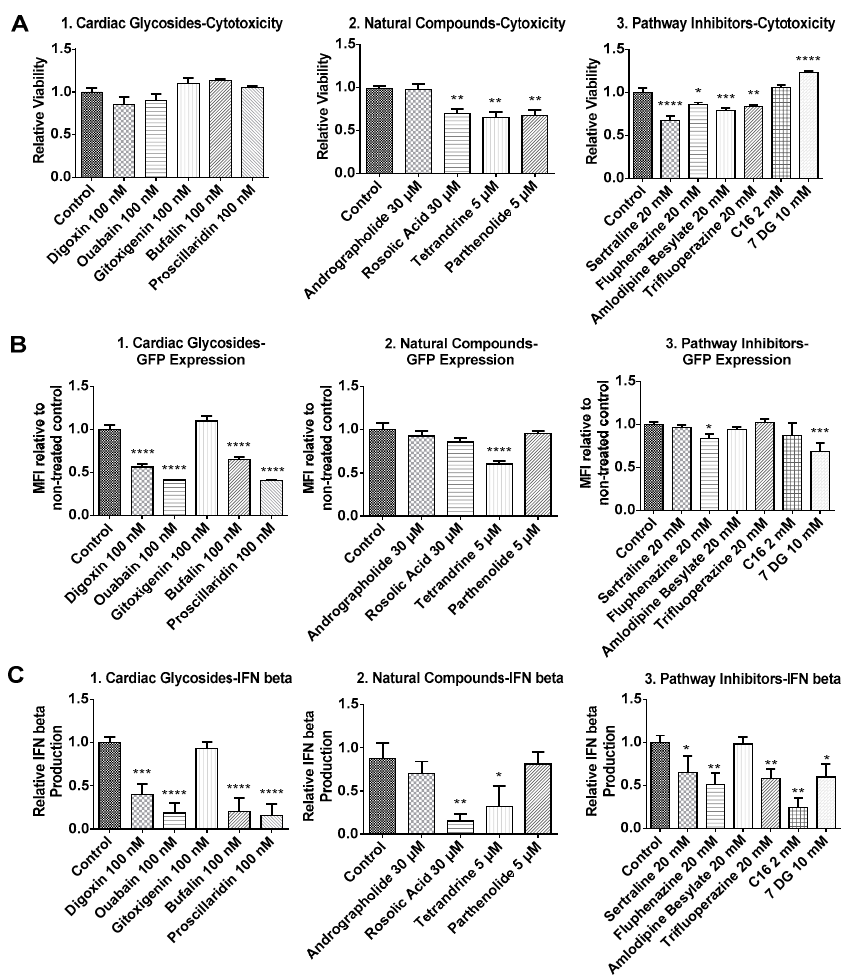
Figure 2. Relative cell viability ( A ), relative green fluorescent protein (GFP) expression ( B ) and relative interferon (IFN)- β production ( C ) of BJ fibroblasts transfected with GFP mRNA following small molecules treatment. Cells were incubated with small molecules for 1h followed by a 3 h transfection with GFP mRNA nanoparticles in the presence of the small molecules. Supernatants were then collected for IFN- β measurement via enzyme-linked immunosorbent assay (ELISA). Cells were further incubated in complete media without small molecules for another 4 h before being assayed for cell viability and GFP expression, respectively. Results were normalized to the average values of control groups that were transfected without small molecules treatment. Histograms of relative GFP expression can be found in Figure S1. * p < 0.05; ** p < 0.01; *** p < 0.005; **** p < 0.0001. MFI: Mean Fluorescence